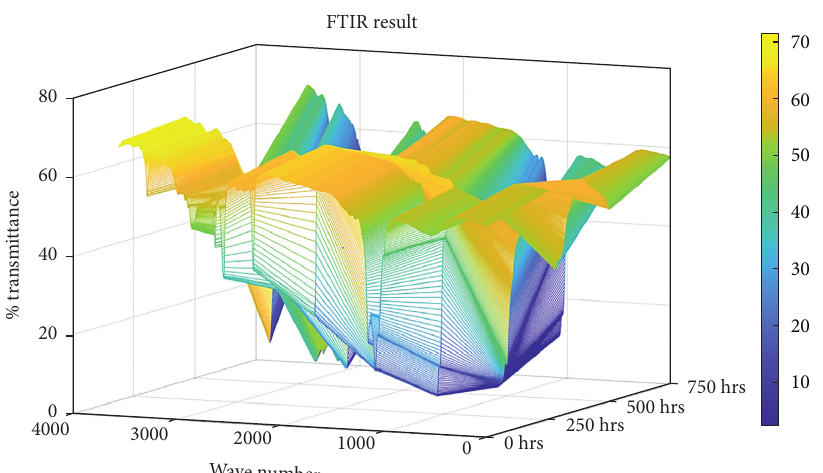
Figure 21: Combined FTIR spectra of all samples of HFDU 68 oil.